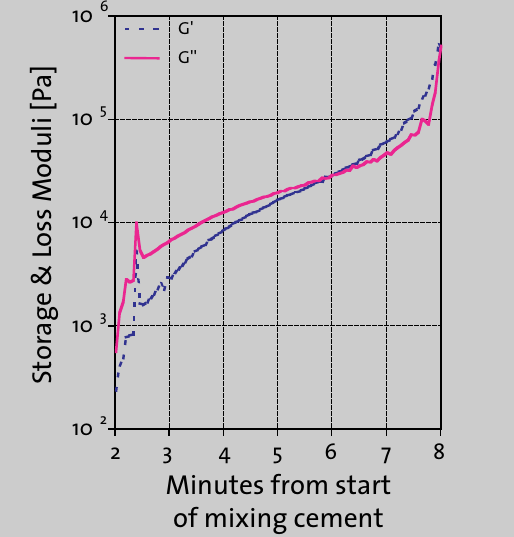
Figure 10: Self-sensed storage and loss moduli of CMW3 bone